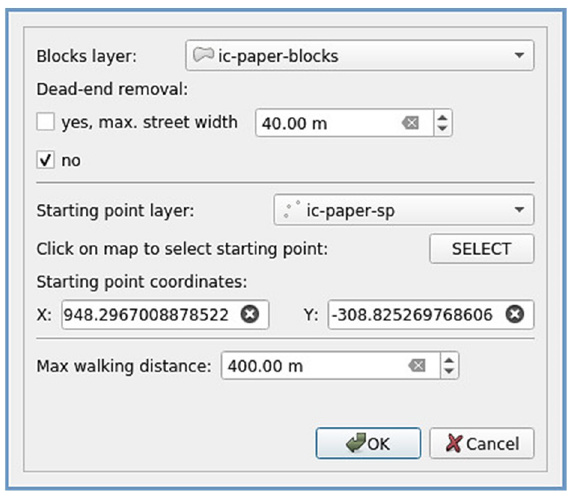
Figure 3. IC (Interface Catchment) QGIS plugin interface.